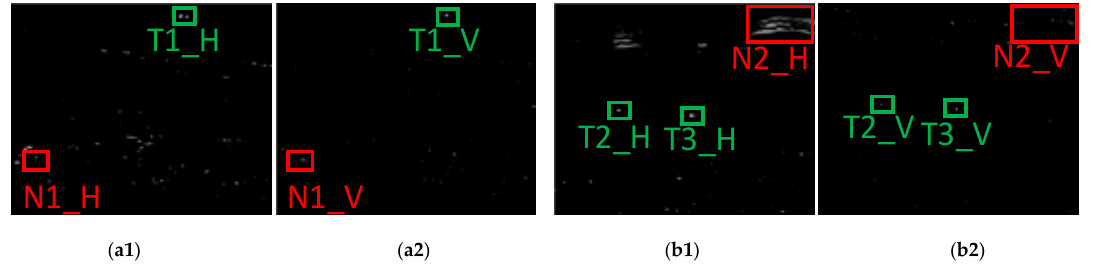
Figure 7. IsD Multi-scale feature fusion results (Algorithm 1). ( a1 ) Image A horizontal fusion. ( a2 ) Image A vertical fusion. ( b1 ) Image B horizontal fusion. ( b2 ) Image B vertical fusion. Algorithm 1: Get the result of multi-scale feature fusion.